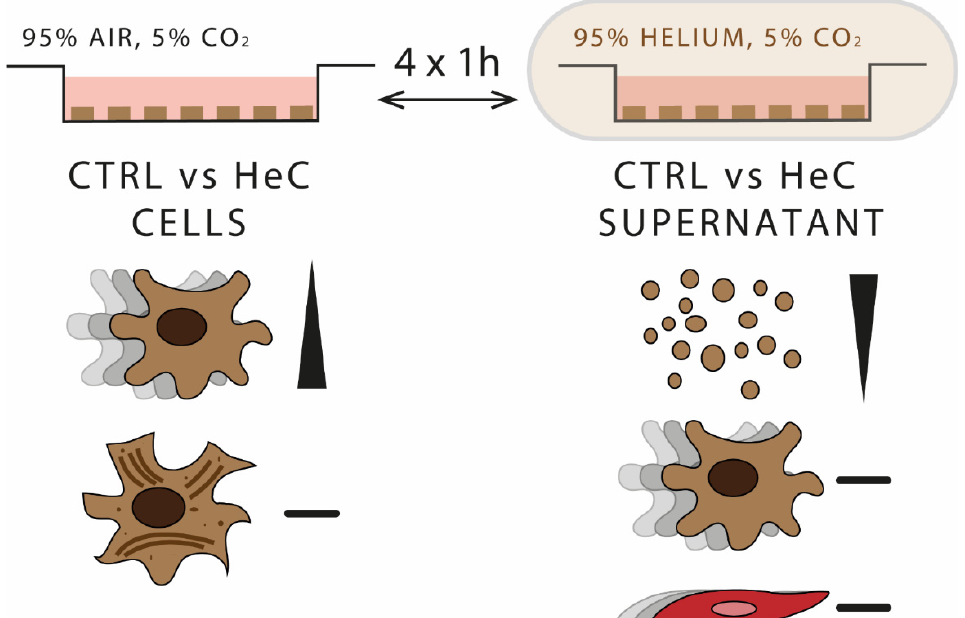
Figure 4. HeC accelerates fibroblast migration without inducing myofibroblast transformation but does not affect fibrosis and angiogenesis via secreted factors. In vitro HeC protocol composed of 4 times one hour 95% helium 5% CO 2 followed by one hour 95% air 5% CO 2 conditions. NRCF cells migrated faster after HeC treatment, but they did not transform to myofibroblasts. mEV concentration tended to decrease in HeC NRCF supernatant. Supernatant of HeC-treated NRCFs did not induce fibrosis or angiogenesis in naïve cells.